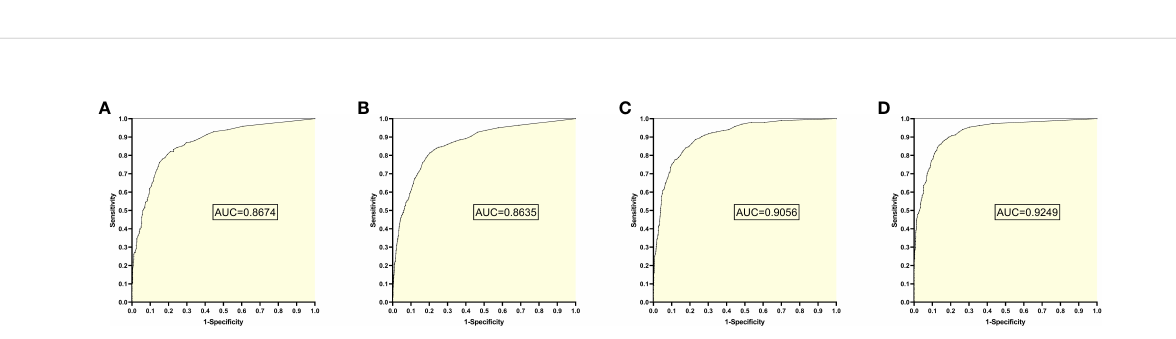
FIGURE 3 ROC curves and AUC values obtained from the training set 2 model testing each test set: (A) results from test set 1; (B) results from test set 2; (C) results from test set 3; (D) results from test set 4.